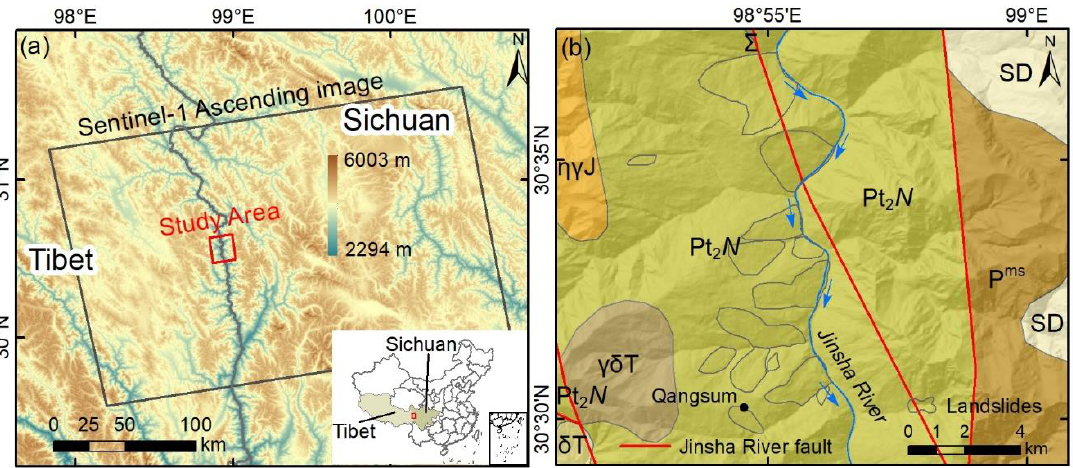
Figure 1. ( a ) Location of the study area and coverage of the SAR datasets; ( b ) tectonic and geological